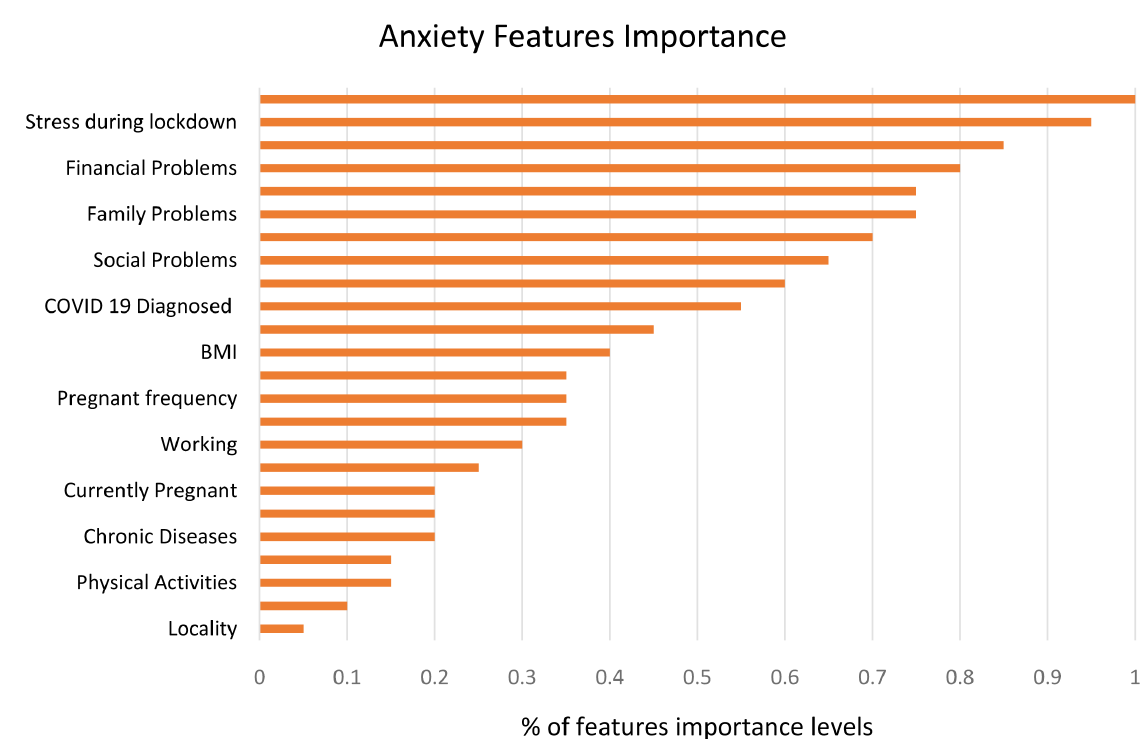
Figure 7. Variables’ importance ranking analysis in predicting anxiety symptoms.